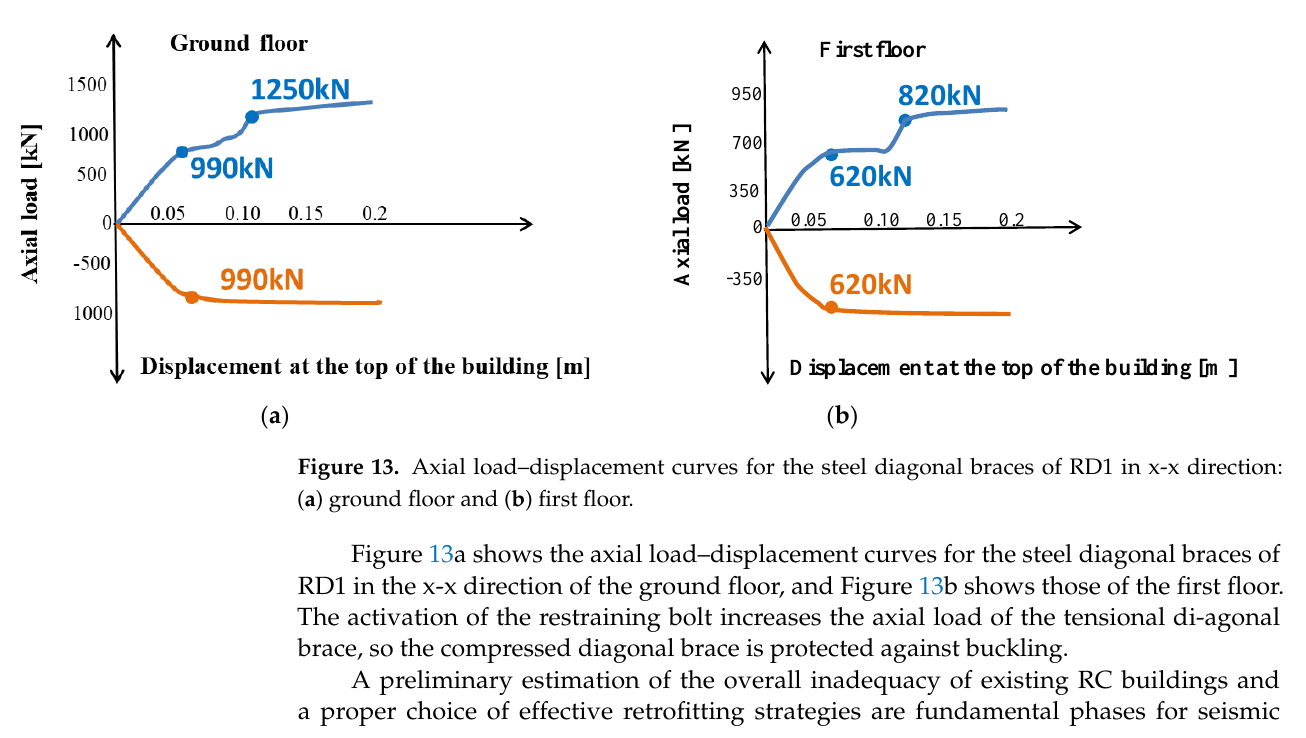
Figure 12. Plastic hinges of redesign buildings for a displacement level of 18.4 cm (at the top) ( a ) RD1 in x-x direction; ( b ) RD1 in y-y direction, ( c ) RD2 in x-x direction; ( d ) RD2 in y-y direction.